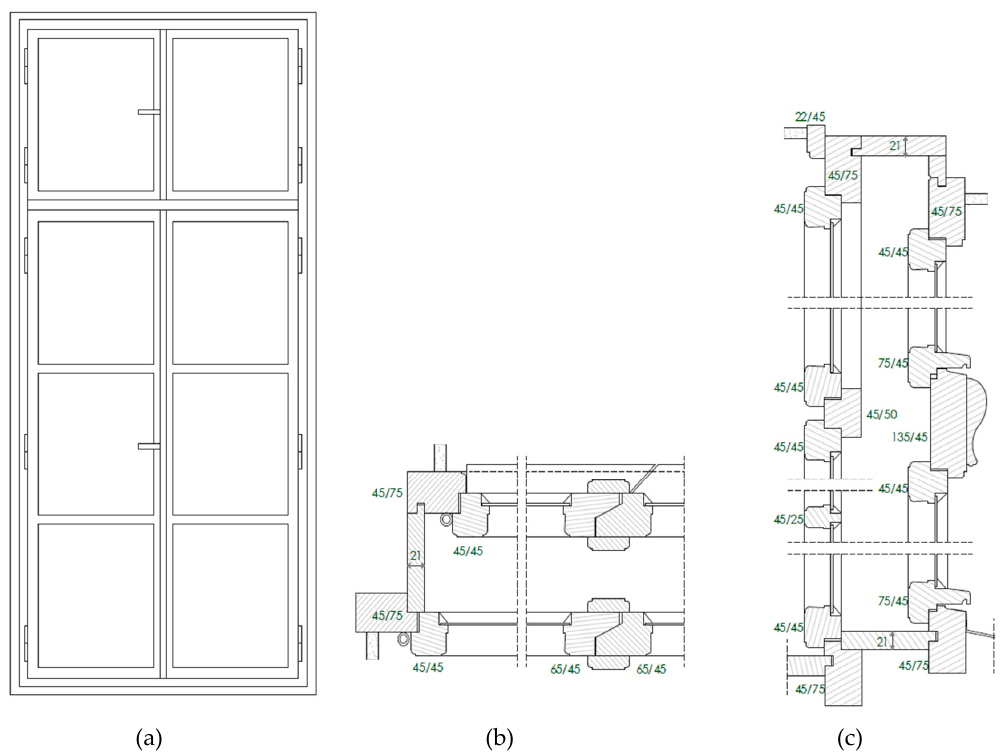
Figure 1. View of typical box-type window ( a ), and the horizontal ( b ) and vertical ( c ) details.